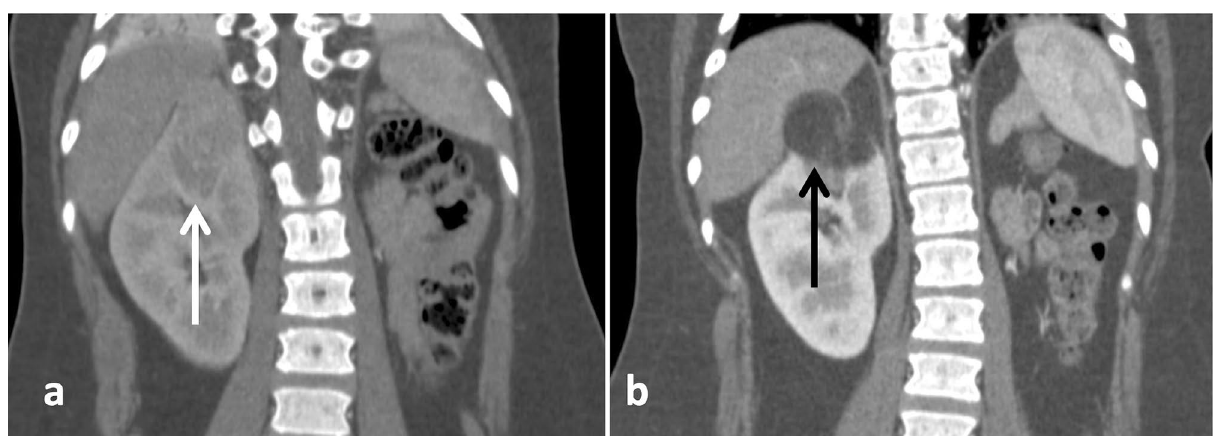
Figure 6. Liposubstitution in angiomyolipoma in response to treatment with sirolimus. Coronal corticomedullary-phase CT images obtained ( a ) before treatment and ( b ) after treatment show the effect of sirolimus treatment on a fat-poor AML in the upper pole of the right kidney (white arrow), revealing the appearance of a fat-rich tumor (black arrow) in substitution to the previous fat-poor